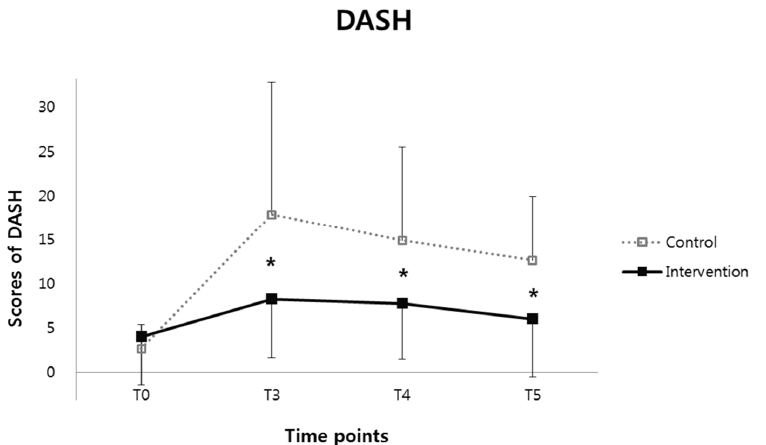
Figure 1. The disability of the upper extremity using disabilities of the arm, shoulder, and hand (DASH) questionnaire and quality of life using a 36-Item Short-Form Health Survey (SF-36) at the preoperative stage (T0), and then 3 months (T3), 6 months (T4), and 12 months (T5) postoperatively. There were significantly lower DASH scores in the intervention group compared with those in the control group with Bonferroni post hoc analysis (* p < 0.05 ). Table 3. The values in disabilities of the arm, shoulder, and hand questionnaire (DASH score) . Control Group